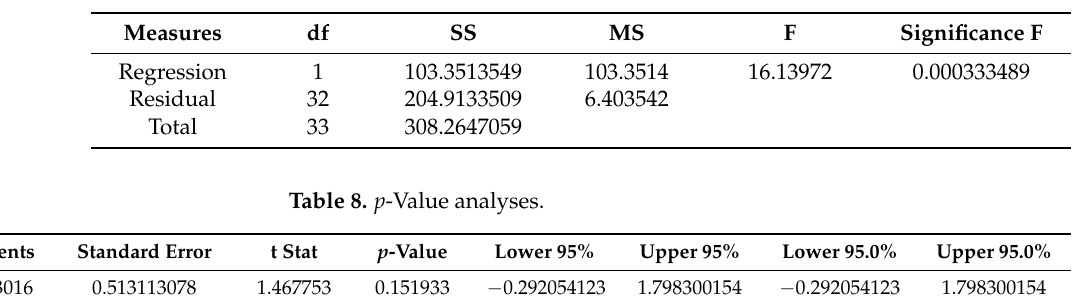
Table 7. ANOVA analyses.